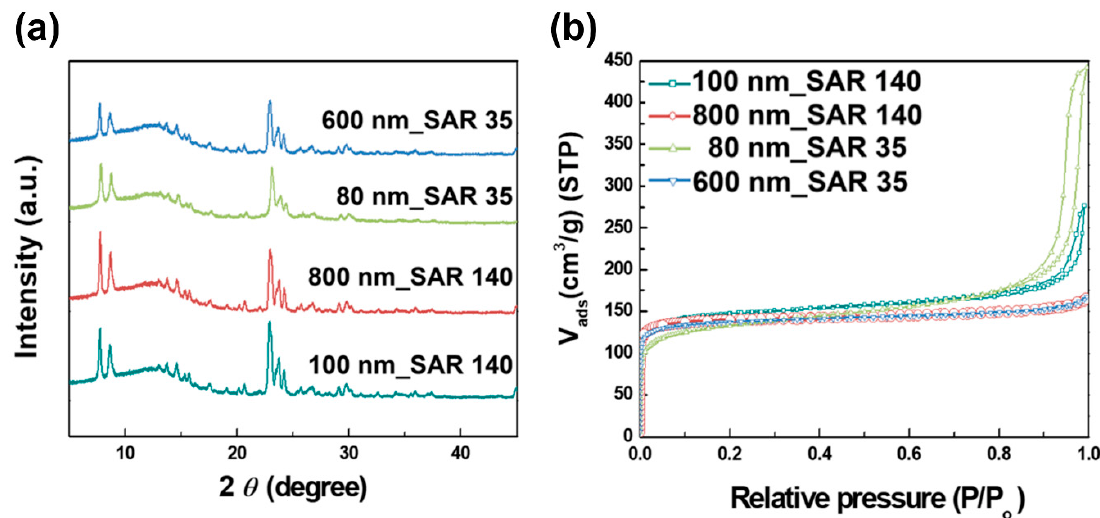
Figure 5. Texture properties of Silicalite-1@Al-ZSM-5 zeolites with different sizes and SARs. ( a ) Powder XRD patterns and ( b ) Ar isotherms of the samples. Table 1. Texture properties of core–shell zeolite samples.